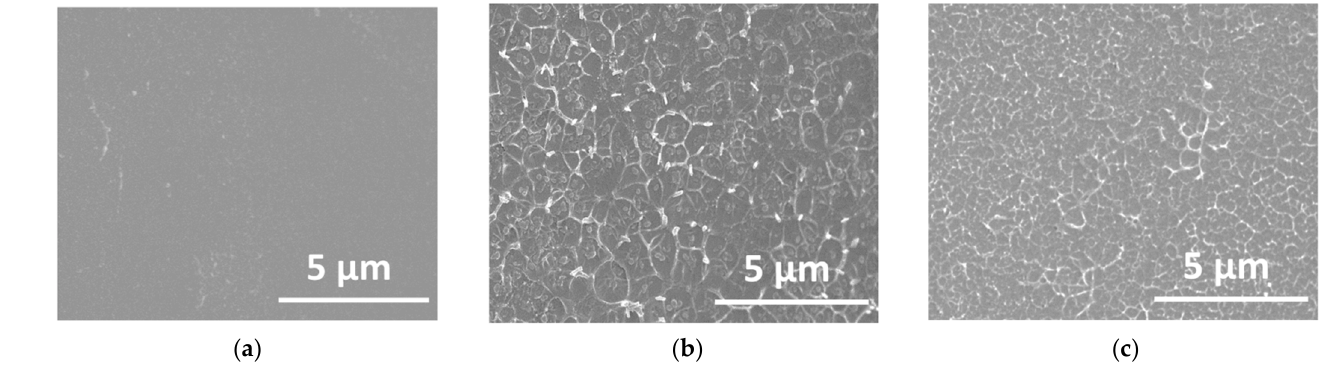
Figure 5. SEM cross-section images of ( a ) SPEEK, ( b ) SPEEK/TpPa − SO 3 H-15, ( c ) SPEEK/TpPa − Py- 15.